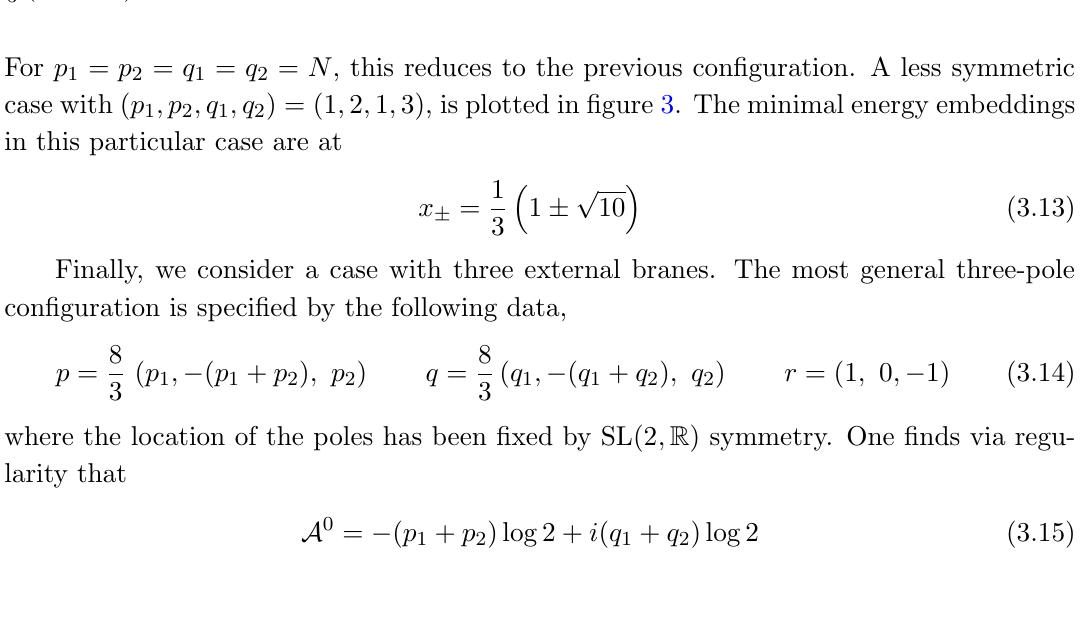
Figure 3 . The function ~ f 2 , evaluated on the boundary of (cid:6) for the semi-symmetric four external 6 brane background of (3.10) with ( p 1 ; p 2 ; q 1 ; q 2 ) = (1 ; 2 ; 1 ; 3). Note the global minima at x (cid:6) = p (cid:0) (cid:1) 1 1 (cid:6) 10 3